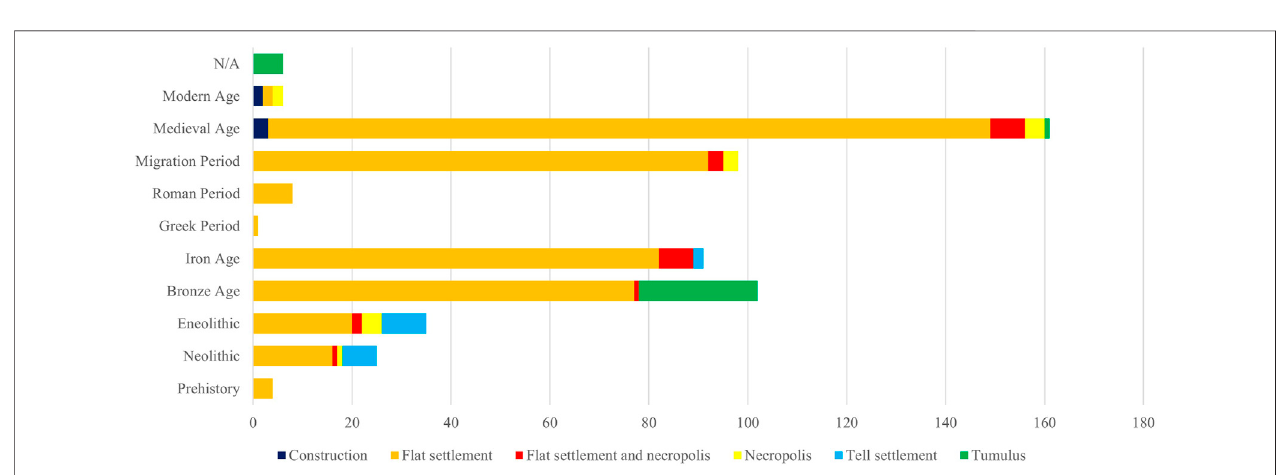
FIGURE 2 | Site distribution on a chronological scale from the study area.